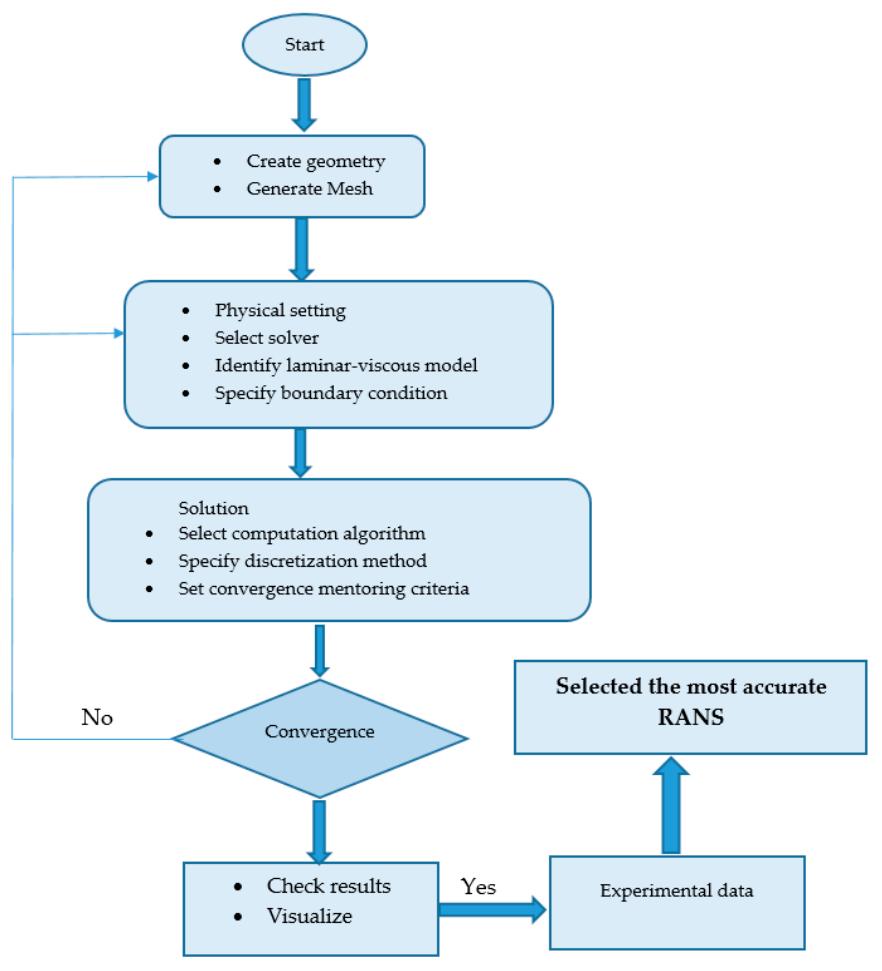
Figure 4. Numerical modelling of HAWT.